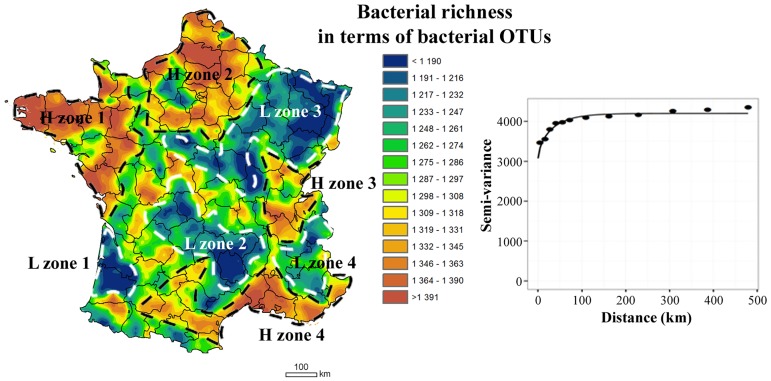
Mapping and robust variograms of soil bacterial richness on the scale of France.The colors indicate the extrapolated values expressed as OTU per soil sample. The L and H zones visually observed on the map correspond to Low and High bacterial richness zones on a regional scale, respectively. In the graph, points represent the experimental variogram, and continuous lines the Matérn models fitted by maximum likelihood method.